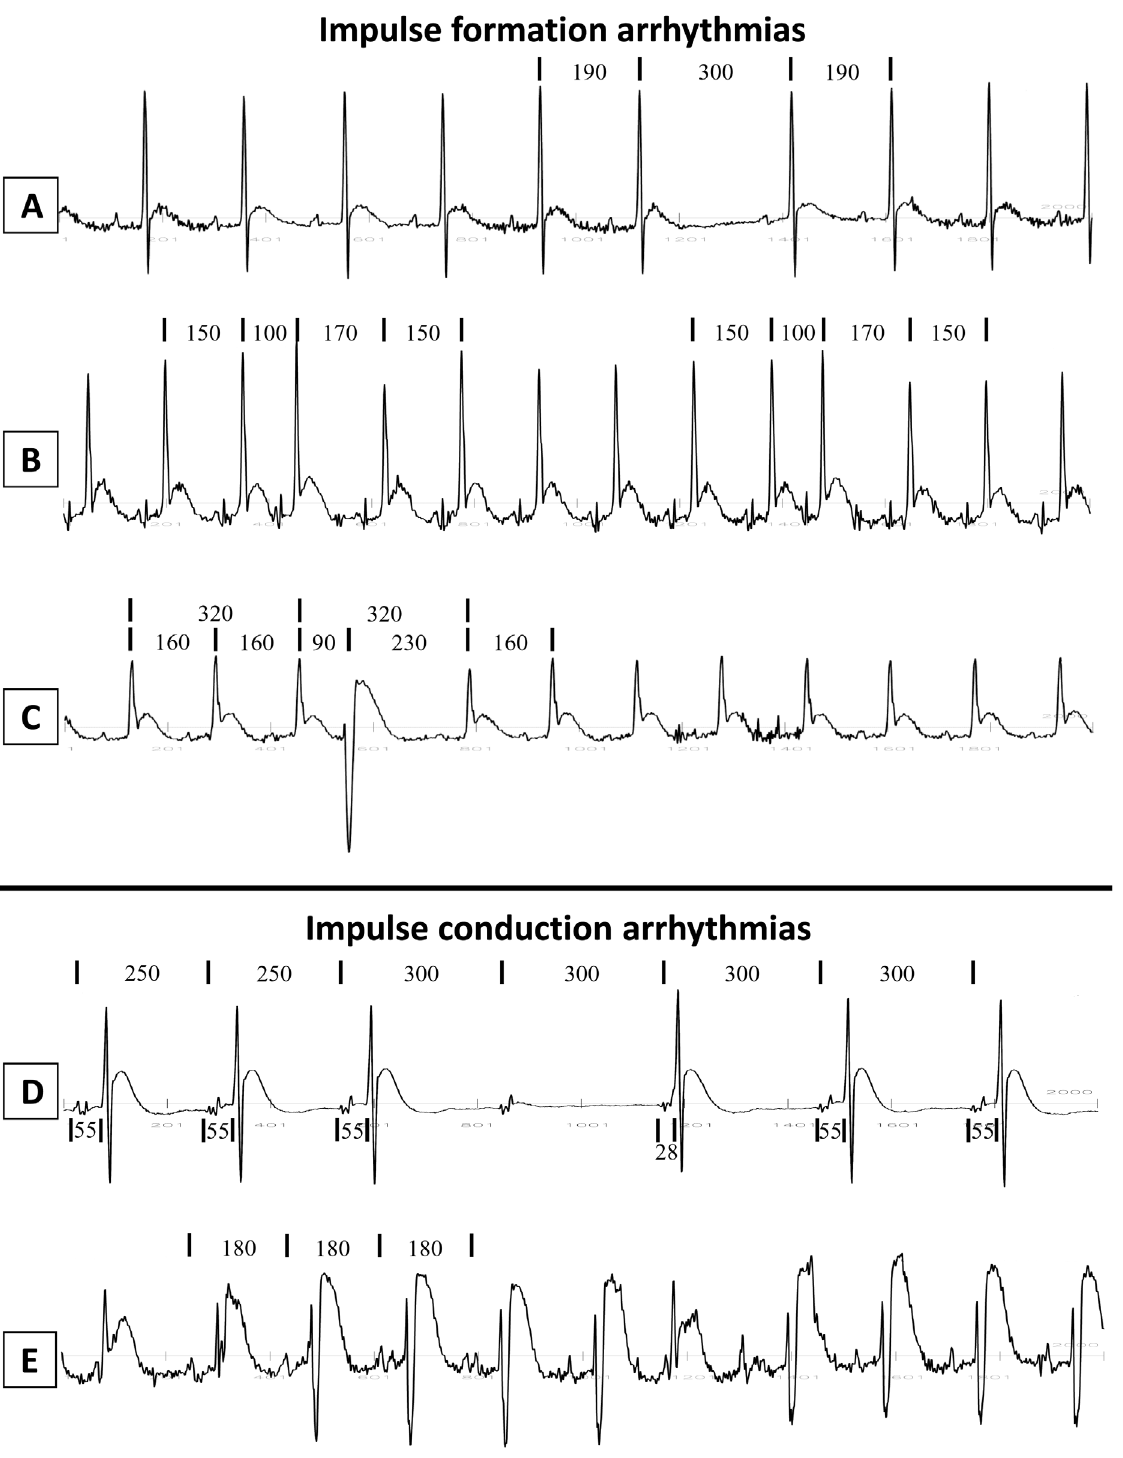
Figure 3. Impulse formation and conduction arrhythmias. Telemetry ECG recordings (2 seconds) of representative arrhythmic events, observed during the six-month period, that belong to the groups of impulse formation arrhythmia (A: sinus pause; B: atrial extrasystoles; C: ventricular extrasystole) and impulse conduction arrhythmia (D: second degree atrioventricular (AV) block with junctional escape beat; E: phasic aberrant ventricular conduction). Numbers identify time intervals in ms.